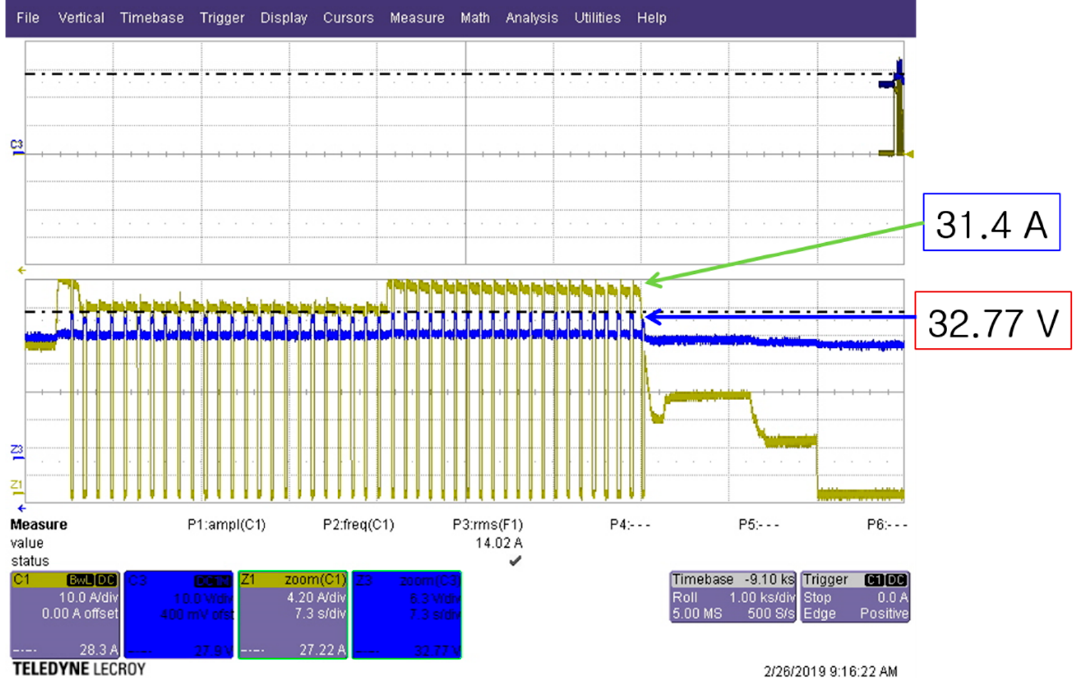
Figure 5. Test results of overcharge protection test.